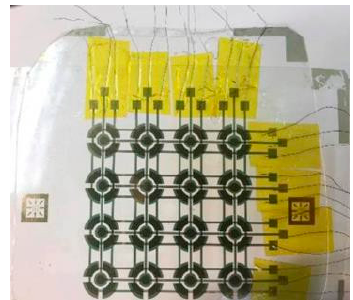
Figure 1. Schematic of the flexible tactile sensor with concentric-shape electrodes.